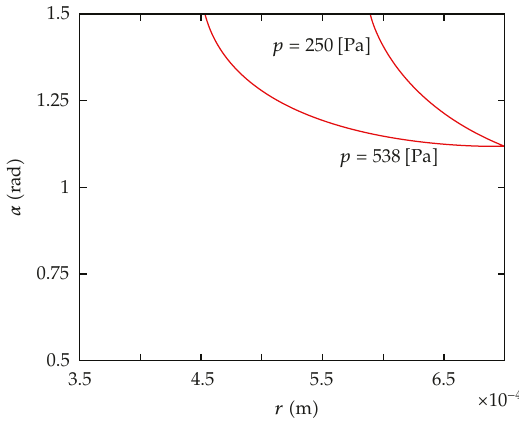
Figure 7: α versus r for p (cid:2) 538 , 250 (cid:5) Pa (cid:7)